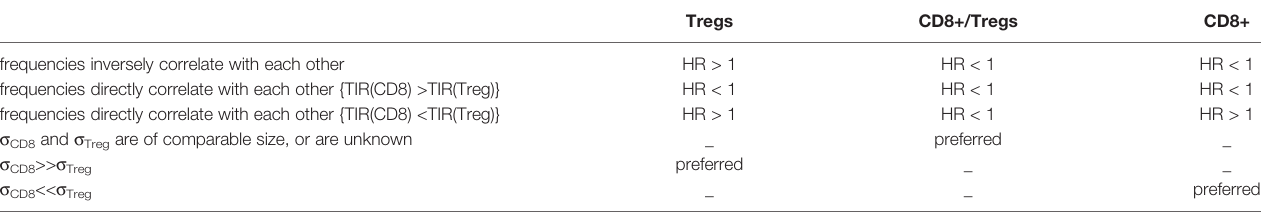
TABLE 2 | A summary table of (a) mortality hazard ratios associated with the use of different intra-tumoral markers; (b) the preferred markers under different relationships between lymphocyte-related variances.